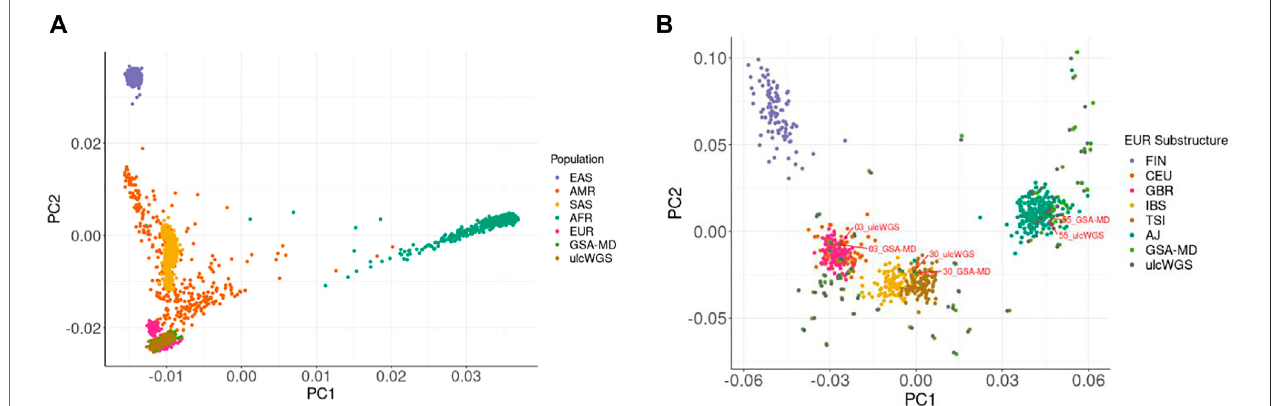
FIGURE 5 | Population strati fi cation of the study cohort using ulcWGS and GSA-MD chip data. We plotted top 2 PCs of the 72 study individuals on top of the 1 KGP phase 3 population (A) . The study population clustered and overlapped with the European ancestries from 1 KGP. In (B) , we added AJ population to the referencepanelofEUR1 KGPphase3andperformedPCAtofurtherre fi netheEURpopulationsubstructure.BothulcWGSandGSA-MDchipsimilarlycaptureddistinct EUR substructures of the study participants, as exampled by the three labeled sample duplicates overlaid on top of the CEU (sample 03), TSI (sample 30), and AJ (sample 55) subclusters. FIN, Finnish in Finland; CEU, Northern Europeans in Utah; GBR, British in England/Scotland; IBS, Iberians in Spain; TSI, Tuscans in Italy; AJ, Ashkenazi Jewish reference; GSA-MD, based on 72 study participants in this study; ulcWGS, based on 72 study participants in this